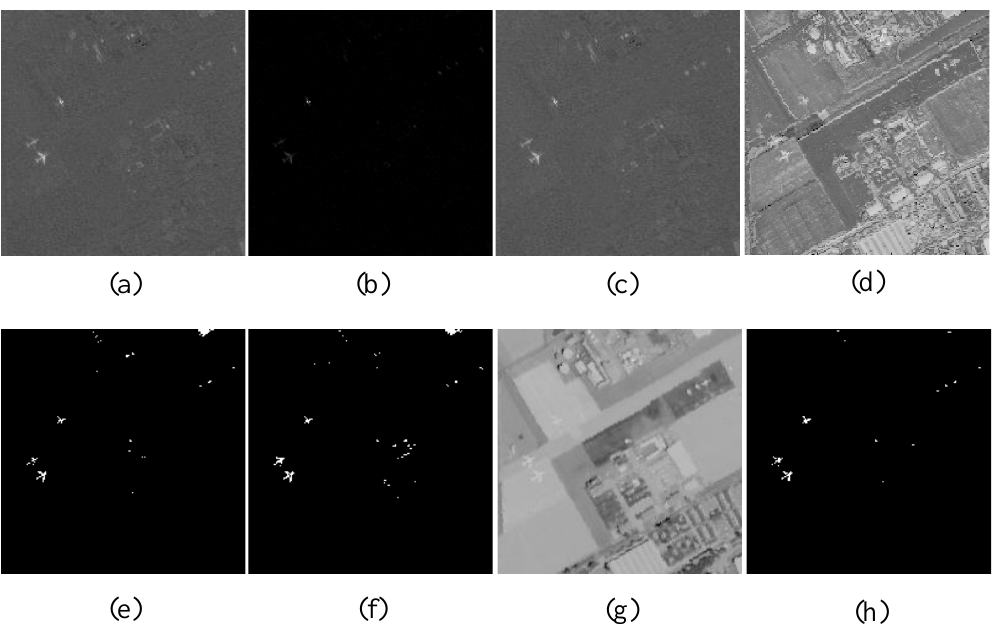
Figure 14. Detection maps for the SpecTIR dataset p f is fixed to 0.1: ( a ) CEM p d = 0.84. ( b ) ACE p d = 0.72. ( c ) MF p d = 0.84. ( d ) SLMD p d = 0.98. ( e ) OC-SVM p d = 0.79. ( f ) SRD p d = 0.95. ( g ) CSCR p d = 0.98. ( h ) Lp-SRD p d = 1.00.